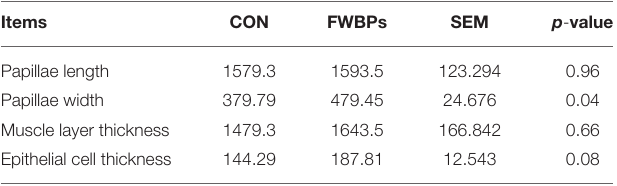
TABLE 3 | Effect of FWBPs on serum metabolic parameters of early-weaned lambs.